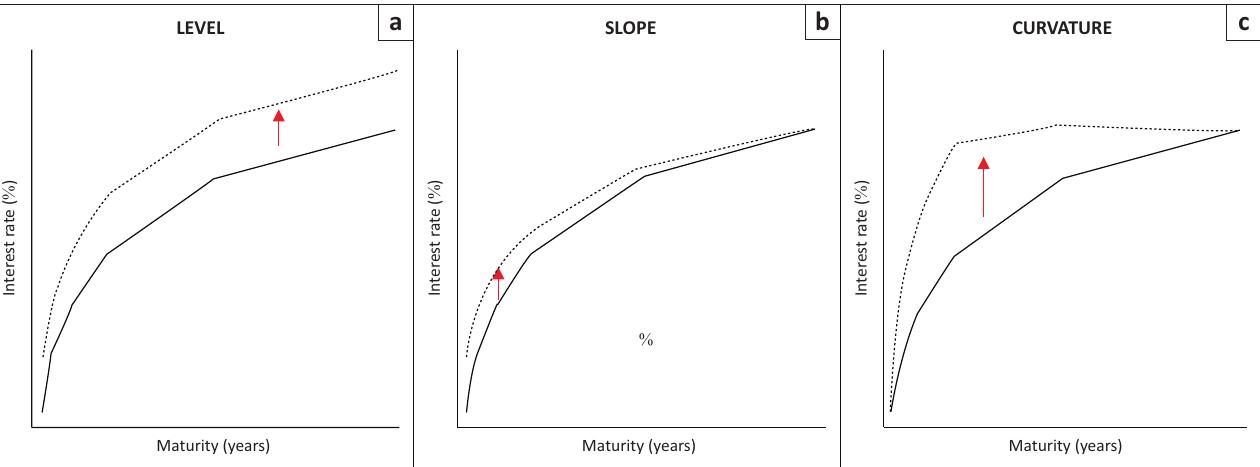
FIGURE 1: Yield curve